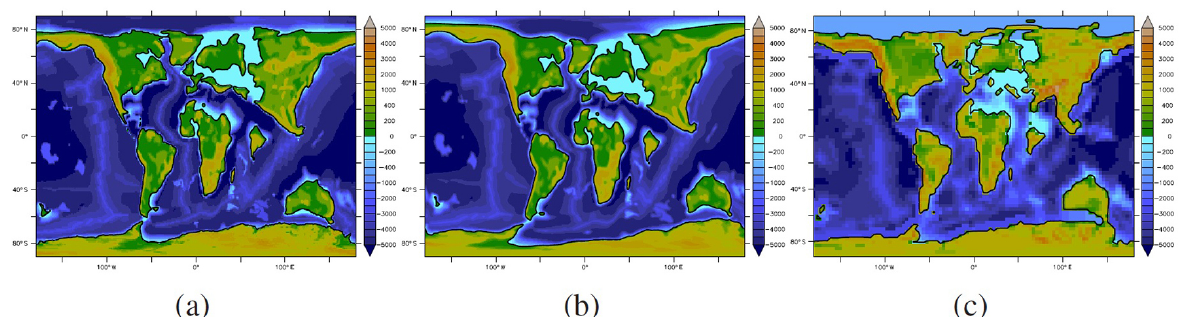
Figure 3. Orography and bathymetry for the palaeoclimate simulations in DeepMIP (metres). (a) The Herold et al. (2014) palaeogeography, as used in the standard palaeoclimate simulations ( deepmip-stand-3xCO2 , deepmip-stand-6xCO2 , deepmip-stand-9xCO2 ). (b) The Herold et al. (2014) palaeogeography, but in the rotation framework given by Torsvik et al. (2012), which is based on a palaeomagnetic reference frame (Baatsen et al., 2016). (c) The Ypresian palaeogeography from Lunt et al. (2016). The location of digital versions of these three palaeogeographies is given in Table